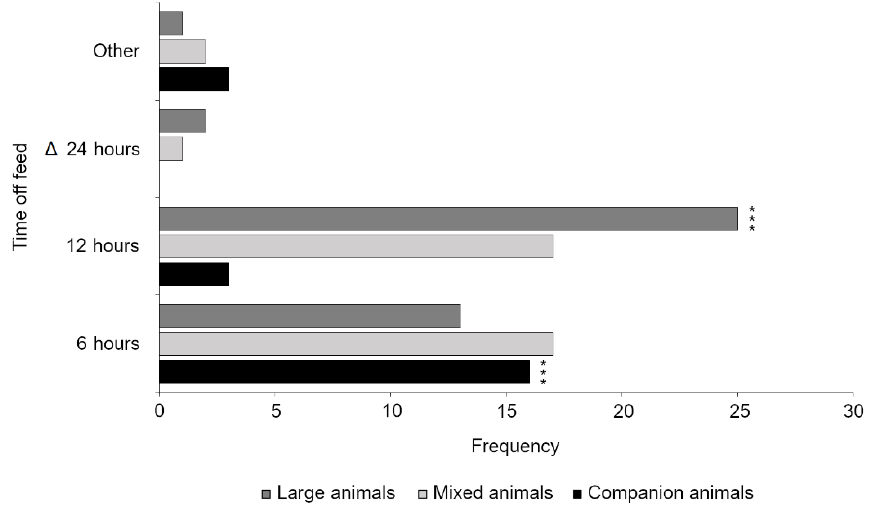
Figure 3. Veterinary opinion on the maximum time off feed prior to slaughter for young calves. The current legislative minimum time off feed for young calves has been denoted by a delta symbol. Significant differences between species emphasis following Bonferroni correction (0.05/9 = 0.006) have been marked with a triple asterisk ( p = 0.001).